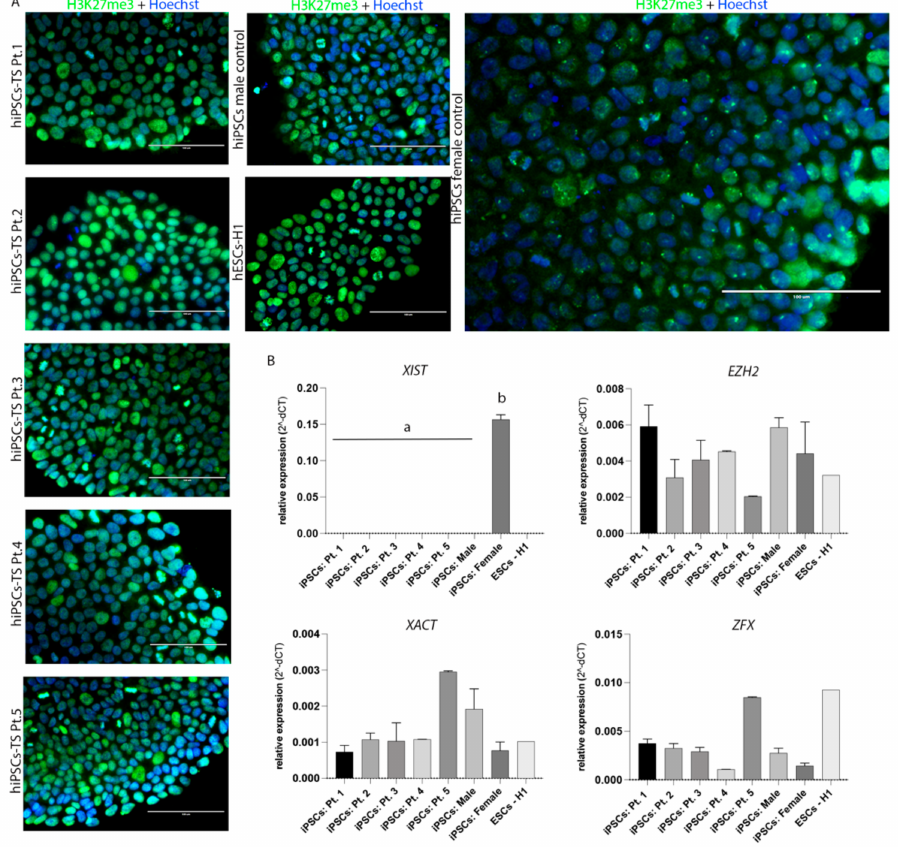
Figure 5. Epigenetic signature. ( A ) Immunofluorescence assay showed the presence of histone H3K27me3 in all lines of hiPSCs-TS and controls. At hiPSCs female control was observed the staining for H3K27me3 in small dots, the Barr corpuscles . Nuclei were stained with Hoechst (blue). Scale bars: 200 µ m and 100 µ m. The data was compiled from at least three technical replicates. ( B ) Quantification of the relative expression of XIST , XACT , EZH2 , and ZFX genes in all hiPSCs lines and colonies (p15). Individual reactions of qRT-PCR were normalized using the B-ACTIN gene. The ESCs-H1 line was used as a positive control and was not considered in the statistical model. All qRT-PCR from hiPSCs-TS and control data were compiled from at least three biological and technical replicates. p values were calculated by Two-way ANOVA, followed by Tukey’s multiple comparisons test as appropriate (letters a-b show difference between groups). Erros bars denote represent